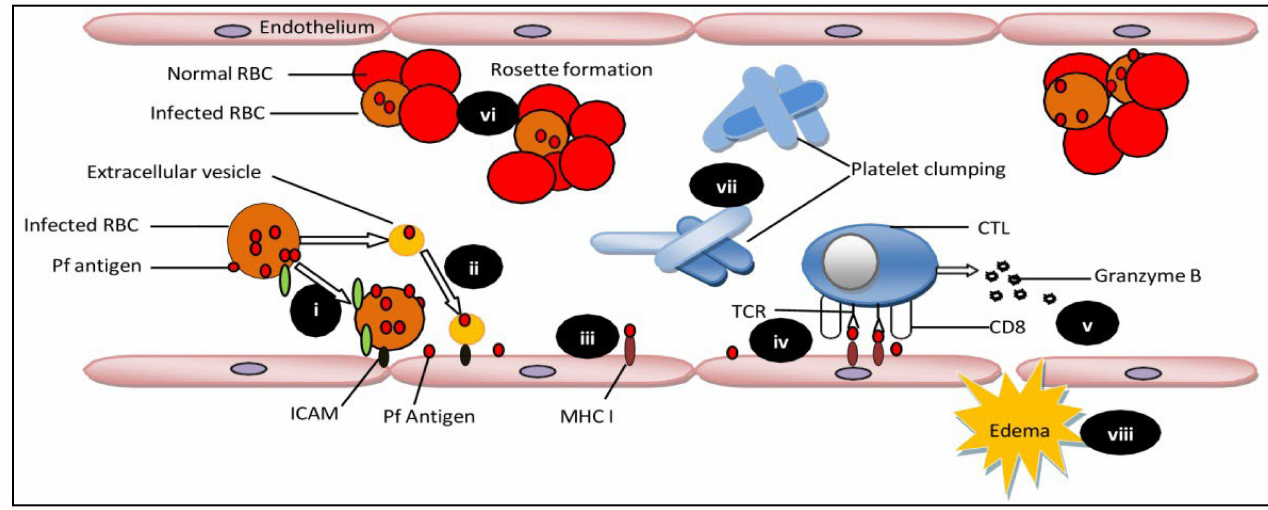
Figure 1. Factors involved in blood-brain barrier breakdown during cerebral